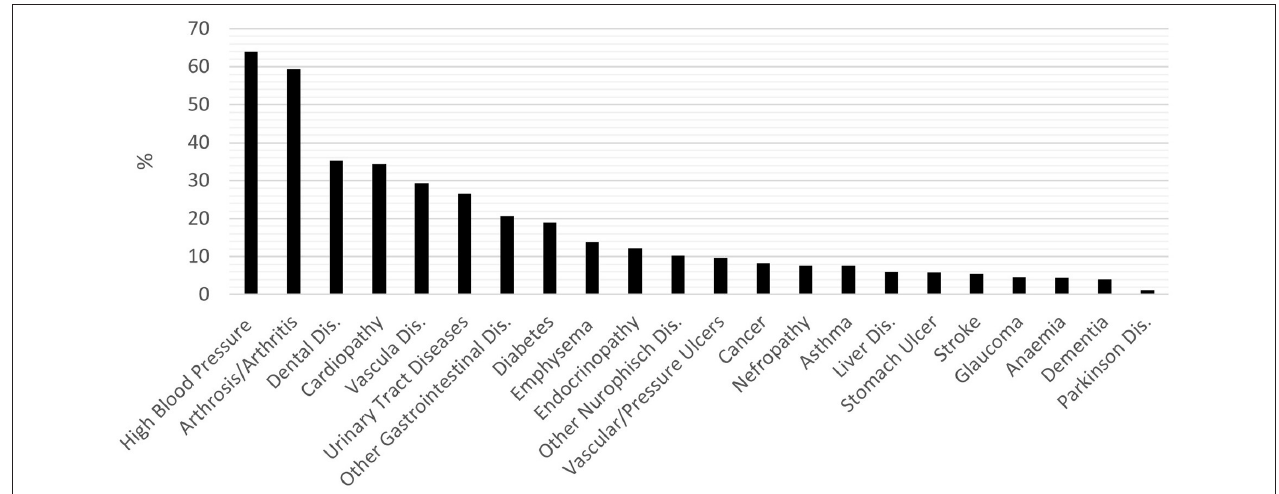
FIGURE 1 | Prevalence of disease among the sample.